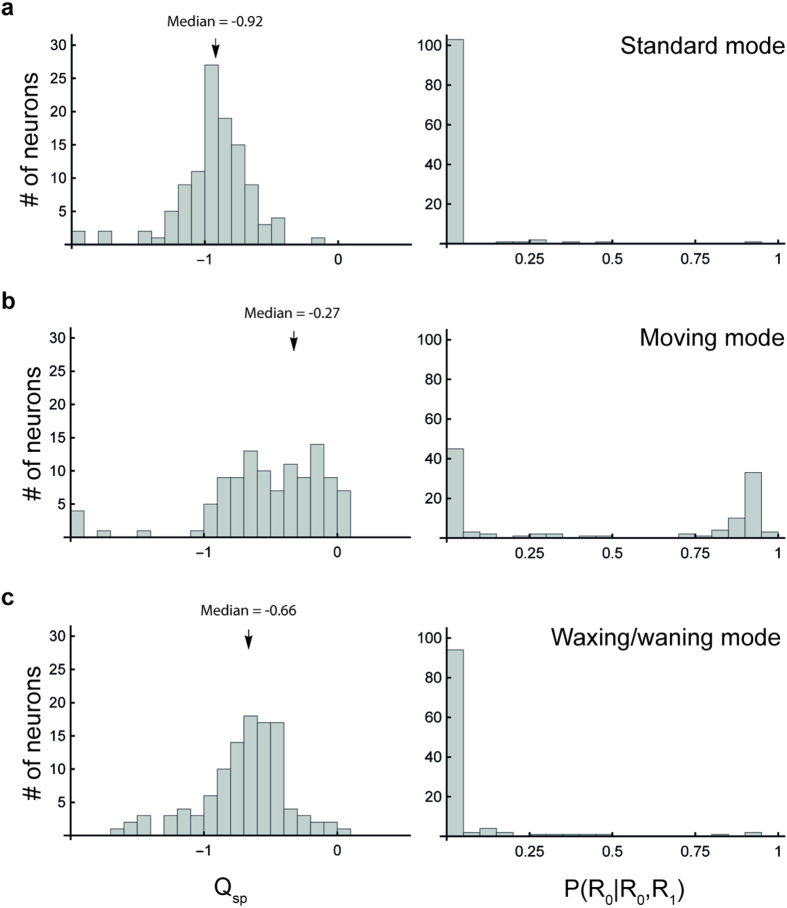
Distributions of Qsp and P(R0|R0, R1) under the stimulation of the 3 modes in MT.(a) Histograms showing the distributions of Qsp, The arrows indicate median values. (b) Histograms showing the distributions of P(R0|R0, R1).